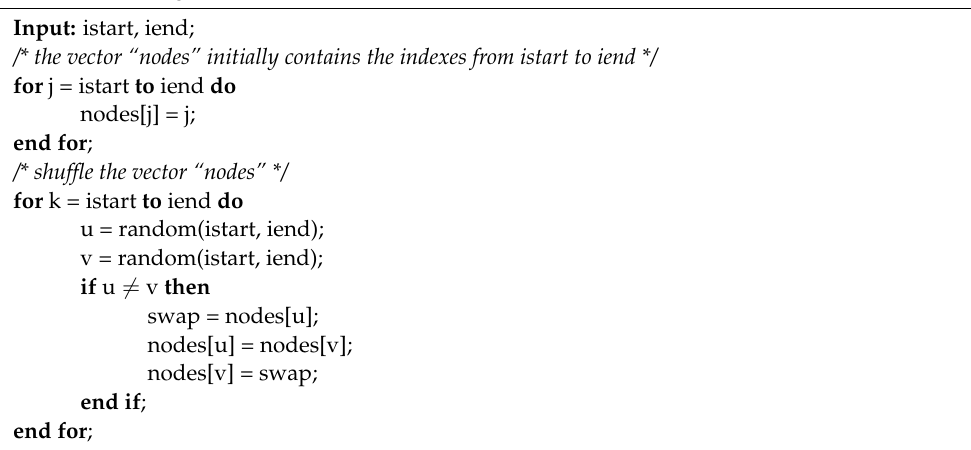
Algorithm 3. Algorithm Shuffled Vector of Nodes (ASVN)